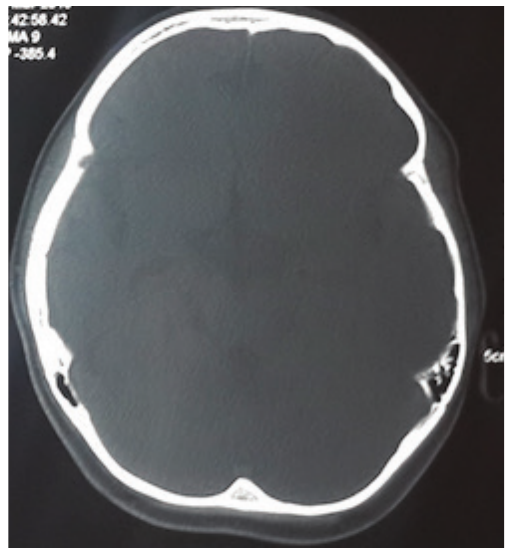
Figure 2: CT-scan head, bone window showing ipsilateral displacement of falxcerebri, elevated right petrous bone and thickened ipsilateral calvarium.